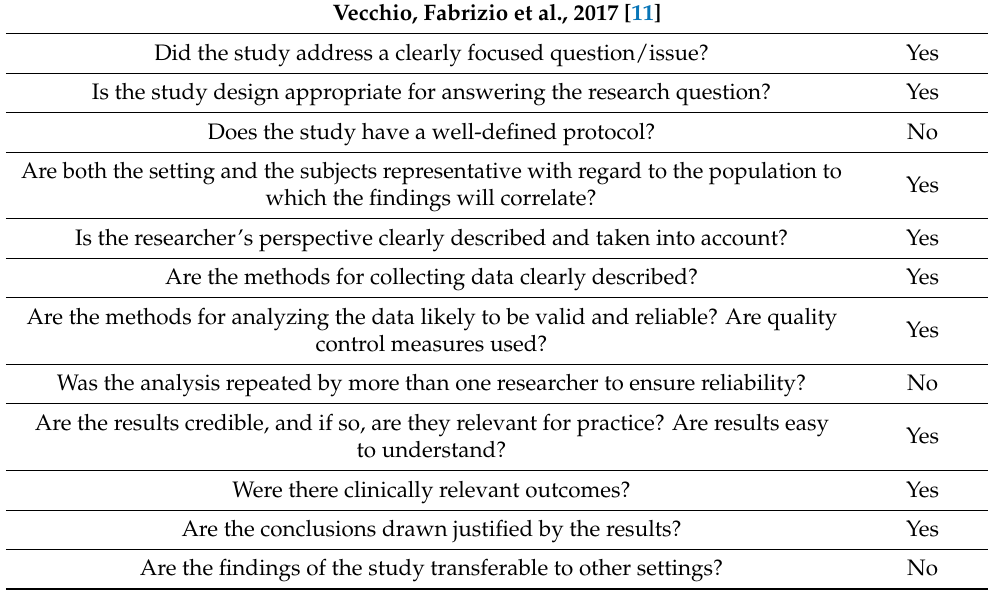
Table 3. Quality assessment for cross-sectional study.